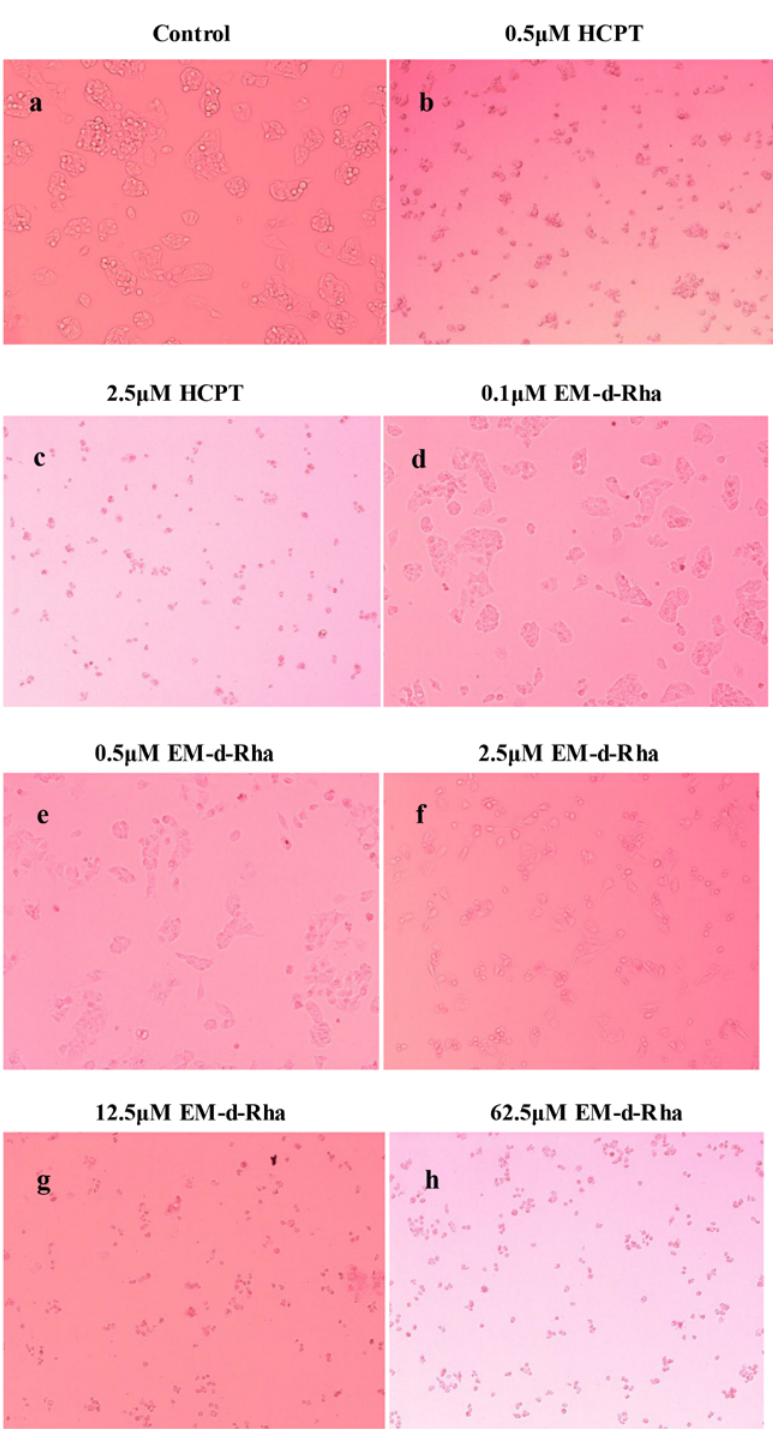
Fig 4. Effects of EM-d-Rha on HepG2 cell morphology. Bright-field microscopy images after incubation with HCPT for 48h at 0.5 μ M; 2.5 μ M and with EM-d-Rha for 48 h at varying concentrations: 0 μ M